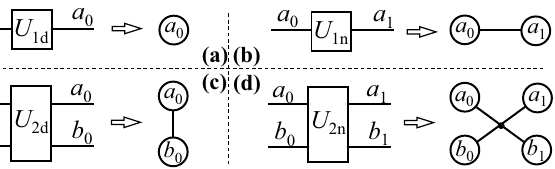
Figure 2. The quantum circuit representations of qubits and gates, and the corresponding undirected graphical model. ( a ) The diagonal one-qubit gate, ( b ) the non-diagonal one-qubit gate, ( c ) the diagonal two-qubit gate, ( d ) the non-diagonal two-qubit gate. The Boolean variables of a 0 , a 1 , b 0 and b 1 represent the bit value of the state, which is 0 or 1. The vertices in the graph corresponds to the Boolean variables in the circuit, and the edges corresponds to the